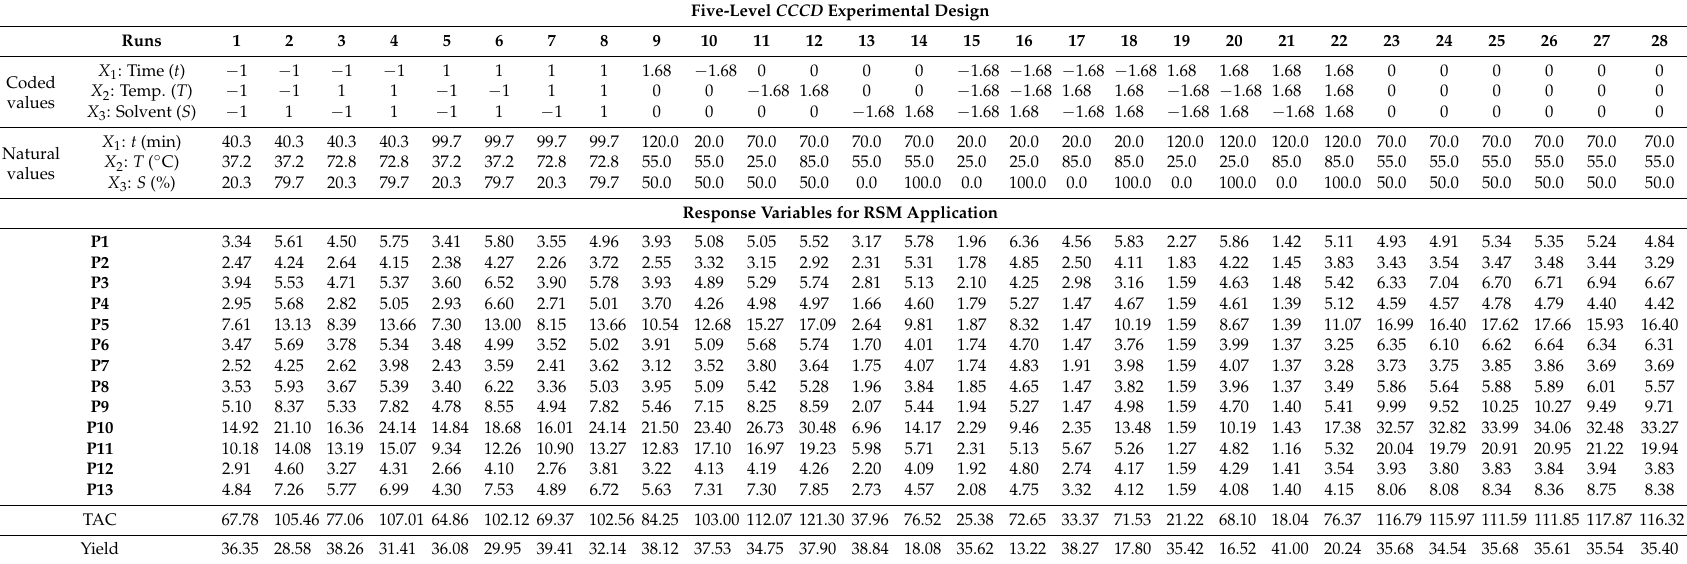
Table 2. The first part describes the experimental design that was applied in this work. The independent variables are presented in coded and natural values. The second part shows the response values for the detected anthocyanin compounds (mg/g E) and extraction yield (%) achieved for all the 28 experimental conditions performed for the HAE by the RSM